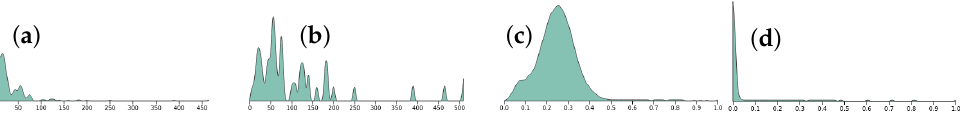
Figure 1. Kernel density estimate plots of the German graph, showing the minimum number of songs ( a ), the maximum number of songs, ( b ) the edge weights after min–max normalization with Box–Cox Transformation ( c ) and without ( d